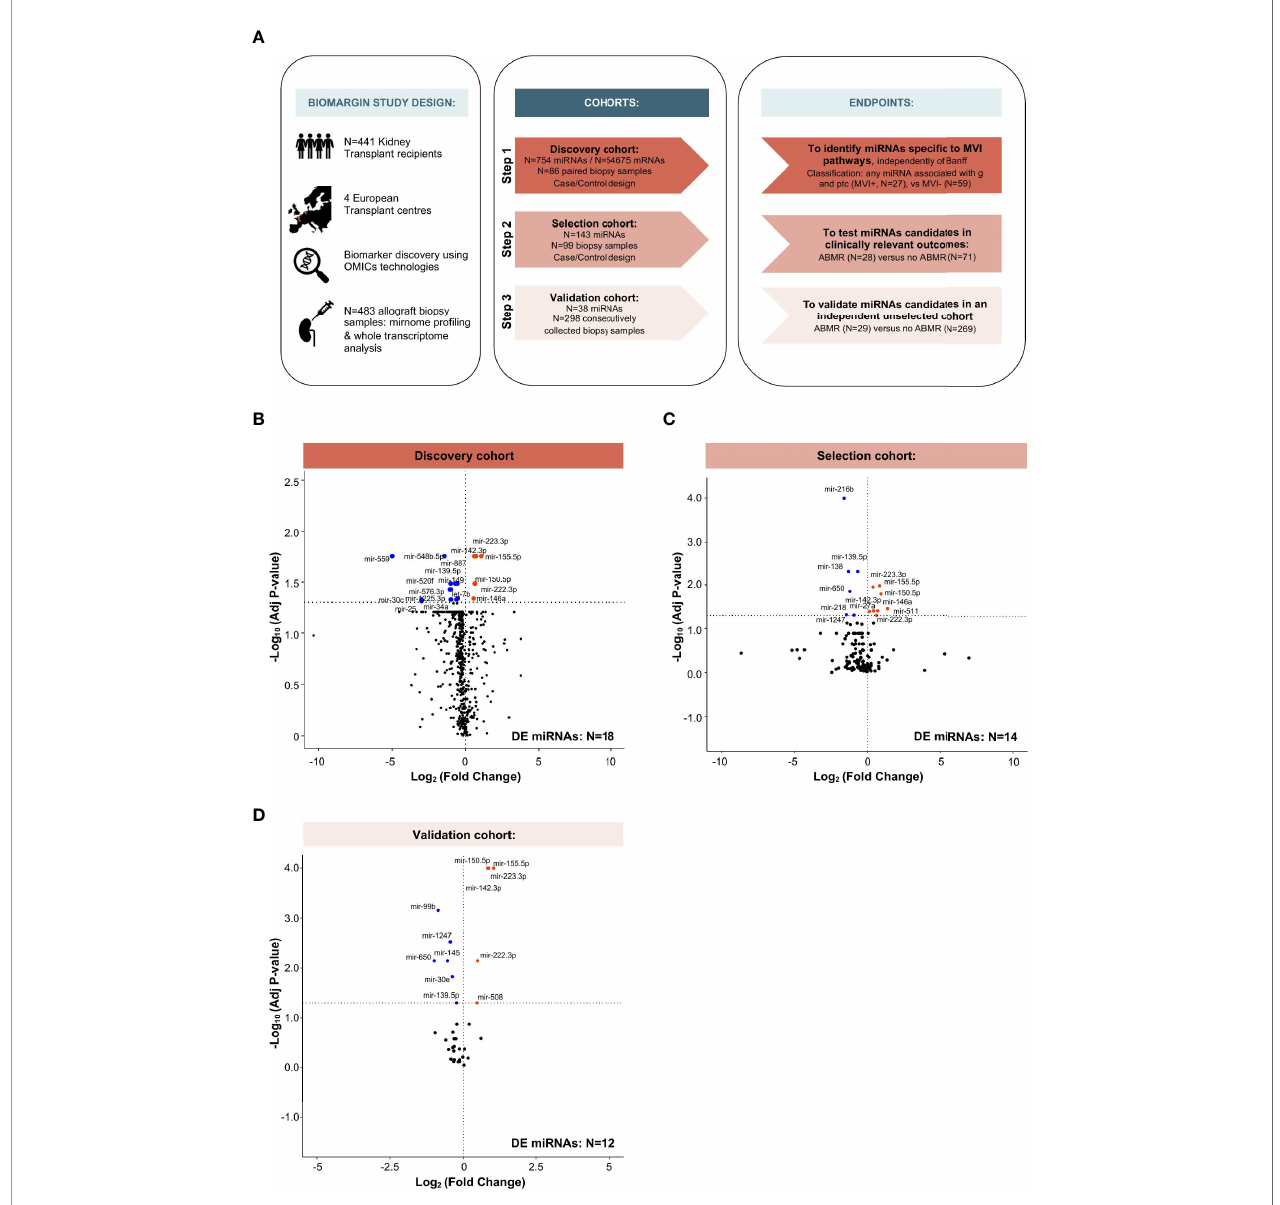
FIGURE 1 | Study design and multi-step identi fi cation of MVI-associated miRNAs in kidney allograft tissue. (A) Study design, cohorts and speci fi c endpoints. (B-D) Volcano Plots displaying the miRNAs differential expression (DE) analysis between MVI+ and MVI- groups (B) or ABMR and no ABMR groups (C, D) across the indicated cohorts. P-values from a Wilcoxon test, with adjustment for multiple testing using Benjamini & Hochberg false discovery rate (FDR) method. Adjusted P-values < 0.05 were considered as signi fi cant (horizontal dashed